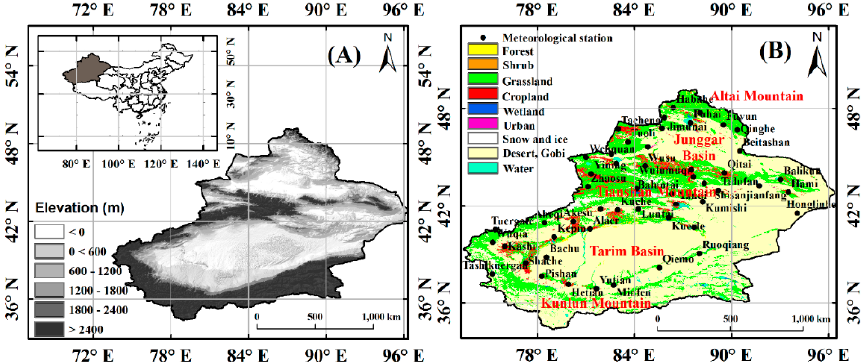
Figure 1. The location of the study area. ( A ) 1-km Digital Elevation Model of Xinjiang; ( B ) Spatial distributions of vegetation types and 51 meteorological stations in Xinjiang. The vegetation type dataset is provided by the Environmental & Ecological Science Data Center for West China, National Natural Science Foundation of China